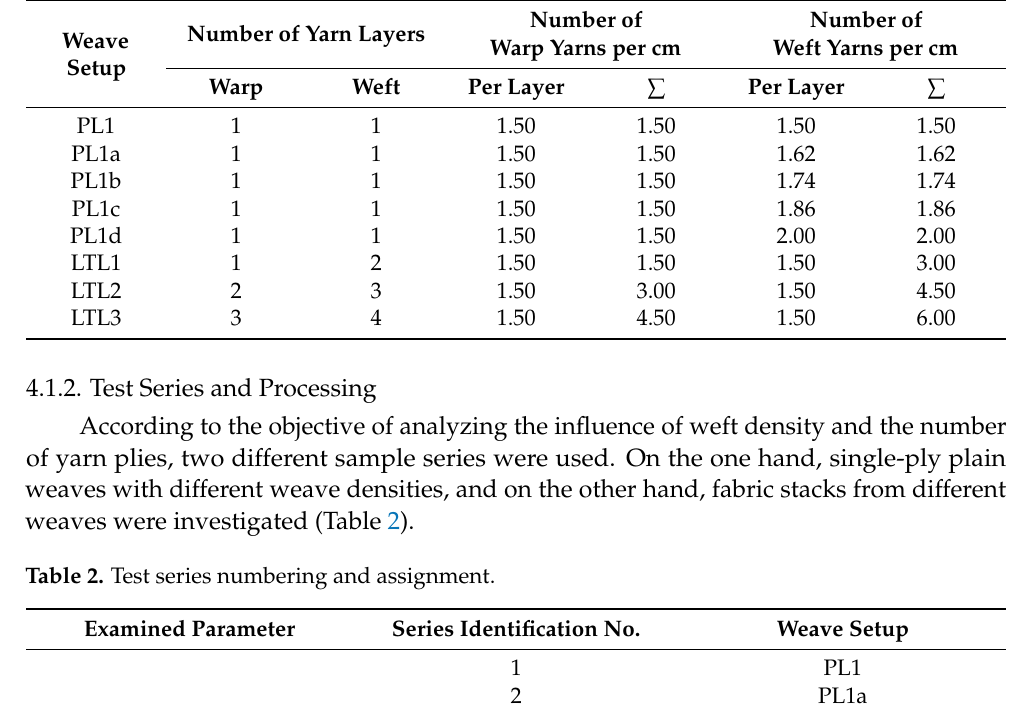
Figure 7. Yarn arrangement in woven fabric preforms (left) and cross-sectional view with substitute diameters. On the one hand, single-layer samples of the respective fabric configuration were investigated and, on the other hand, multilayer stacked samples. In this way, the resulting composite wall thickness in each case is determined using 2 up to 10 fabric layers stacked on top of each other. The structure of the individual layers investigated and an overview of the fabric configurations are shown in Figure 5 and Table 1. Table 1. Overview of examined woven fabric preform configurations.